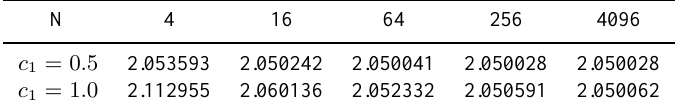
Table 1. Case d = 1 , m = 1 (quadratic splines).